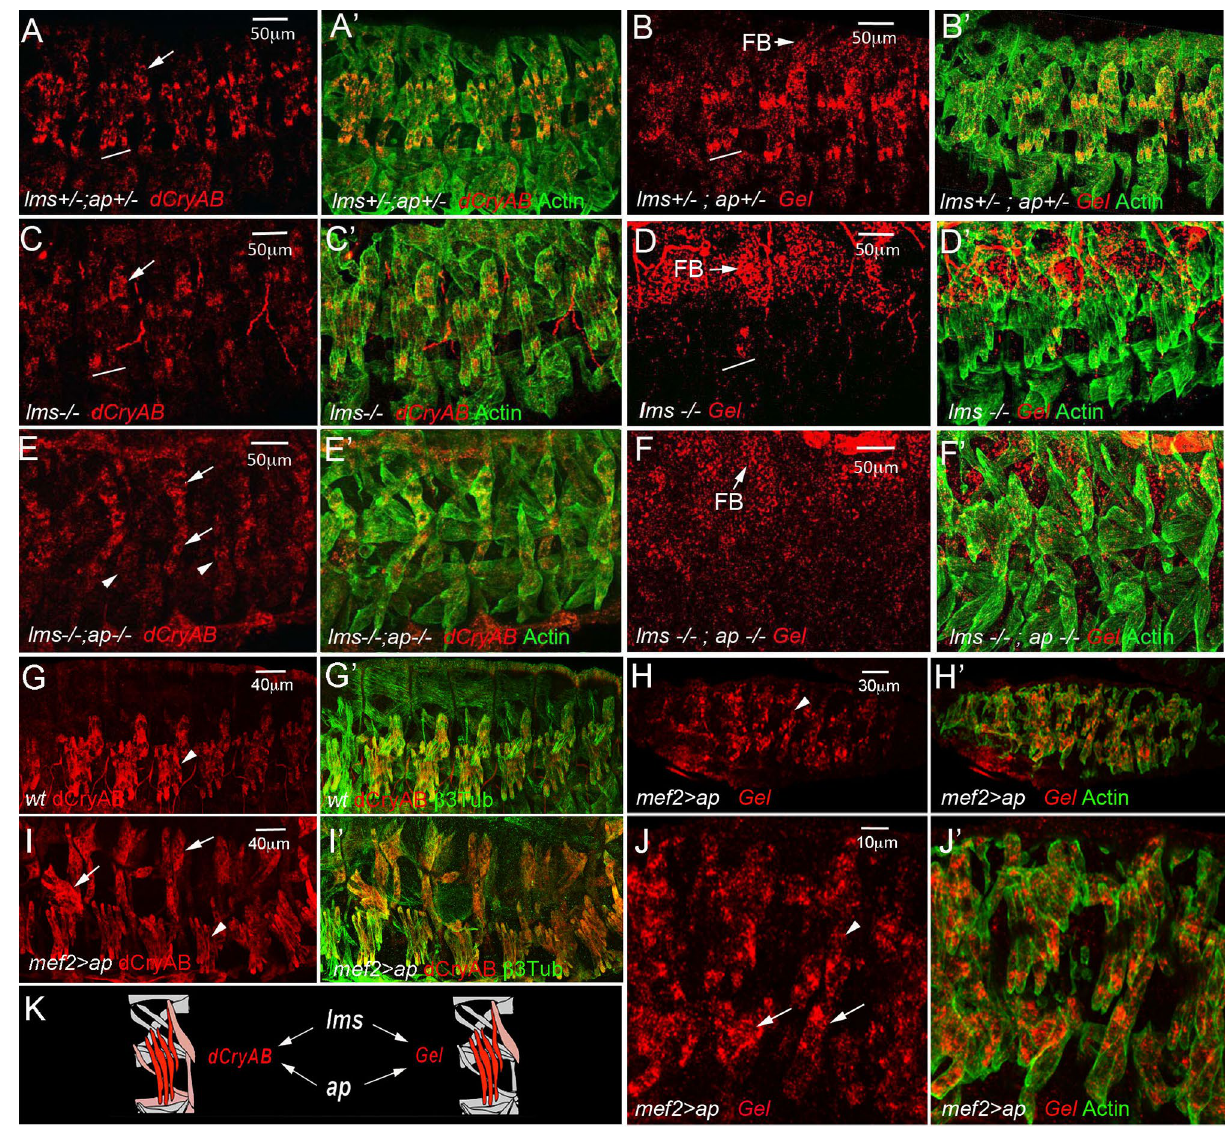
Figure 2. Lms and Ap positively regulate the expression of dCryAB and Gel in LT muscles. dCryAB and Gel transcript expression were analysed in heterozygous lms + /-;ap + /- ( A–B ′ ) embryos, in single lms-/- mutant embryos ( C–D ′ ) and in double lms-/-;ap-/- mutants ( E–F ′ ) by in situ hybridisations with dCryAB or Gel RNA probes. ( A–B ′ ) Both dCryAB and Gel are prominently expressed in LT muscles of heterozygous lms + /-;ap + /- embryos. By contrast, dCryAB transcript levels are reduced in LTs (underlined area) in simple lms-/- mutants ( C–C ′ ) compared to ( A, A ′ ). Note that in lms mutants, dCryAB expression in DT1 remains unaffected (arrow). dCryAB down-regulation in a few remaining LTs is even more apparent (arrowheads) in double lms-/-;ap-/- mutants in which dCryAB expression in SBM and in DT1 is still detectable (arrows). Gel LT expression in the lms-/- context has almost completely vanished (underlined area) in ( D ) compared with ( B ), whereas its expression in the fat body (FB) remains high. No LT associated Gel expression could be detected in double lms-/-; ap-/- mutants. Note that Gel expression in FB could still be detected ( F ). Conversely, pan-muscular expression of ap using Mef2-Gal4 driver induces both dCryAB (compare G, G ′ , with I, I ′ ) and Gel expression ( H, H ′ , J, J ′ ) in all muscles. Arrowheads point to LT muscles and arrows point to ectopic expression in dorsal ( I ) and ventral ( J ) muscles). ( K ) Schematic representation of dCryAB and Gel transcriptional expression needs to be turned down while muscle differentiation progresses. By contrast, Cluster 2 showed a significant enrichment of several GO terms related to muscle development (Fig. 1F) including conserved genes encoding actin-binding proteins: CG34417/Smoothelin, flr/WDR1, CG18135/Gpcpd1, sals/SCAF1, Actn/ACTN2, Gel/GSN, TpnC41C/CALM1, dCryAB/l(2)efl/CRYAB (Fig. 1G). We found this sub-cluster of particular interest as it contains genes with similar biological functions and differential Lms- versus Slou- transition profiles. Among them, Gel and dCryAB with “up-up” transition profile in the Lms subpopulation (Fig. 1G) are both preferentially expressed in Lms-positive LT muscles (Fig. 1H). Drosophila Gel belongs to the conserved Gelsolin/Villin family of